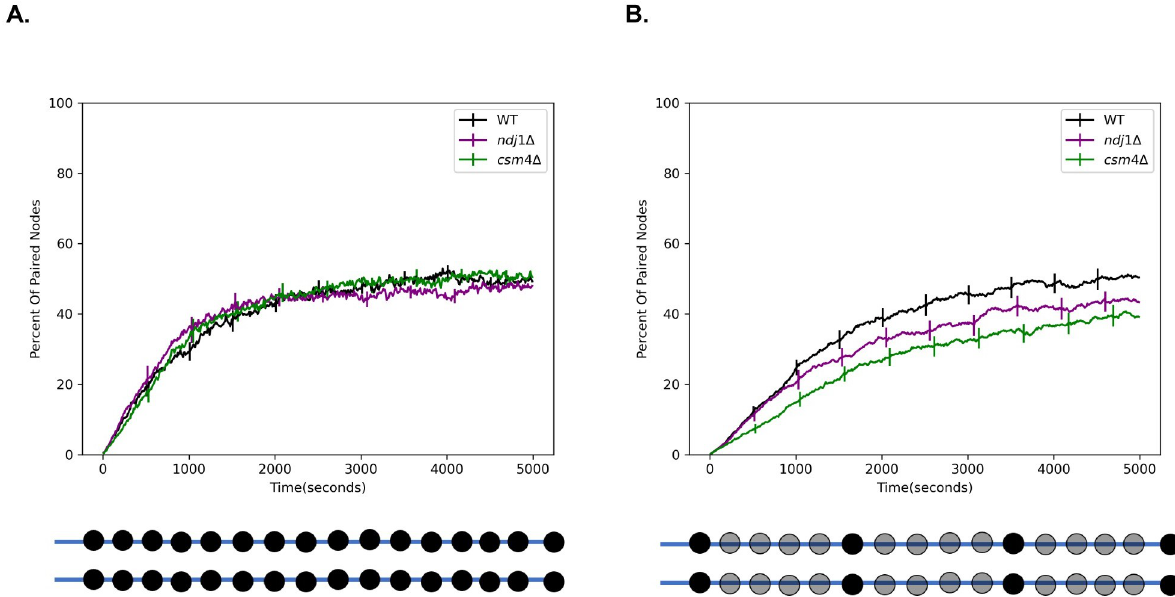
Fig 3. Rapid telomere movement accelerates homologous chromosome pairing. (A) Percent of paired nodes vs time for the case that pairing occurs along the entire chromosome. The mutant strains ndj1 Δ and csm4 Δ pair with the same kinetics as WT. (B) Percent of paired nodes vs time for the case that pairing sites are spread out along the chromosome. RTMs increase the rate of pairing of wildtype (WT) as compared to the mutant strains. Error bars indicate 95% confidence intervals.